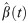
Parameter setting based on Example 2 and τ = 0.5.The solid curves true function β(t); dotted line estimated function β^(t).